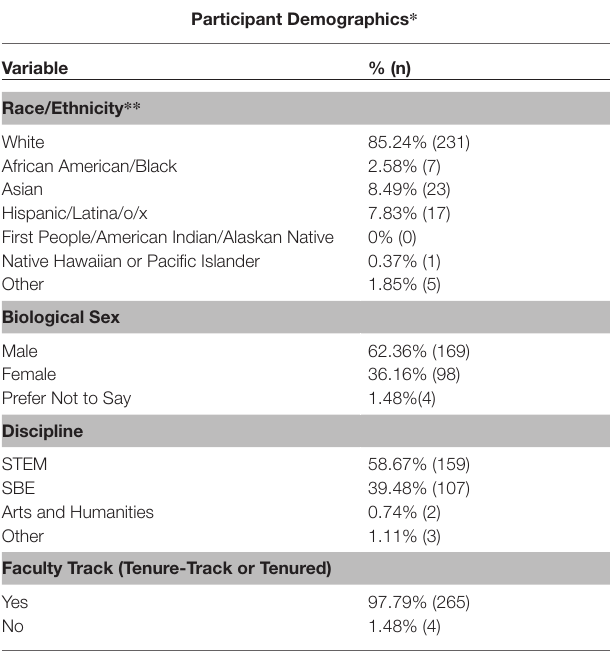
TABLE 1 | Participants’ demographic